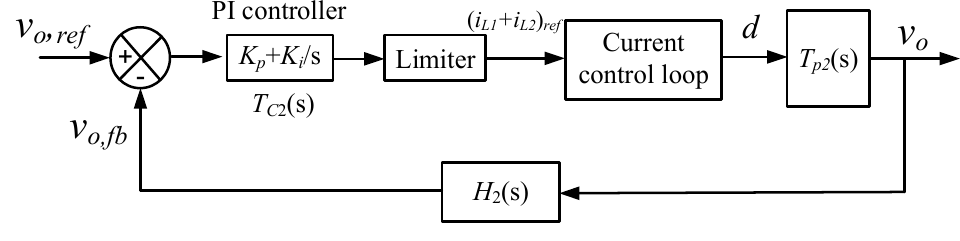
Figure 10. Outer voltage control loop schematic diagram.